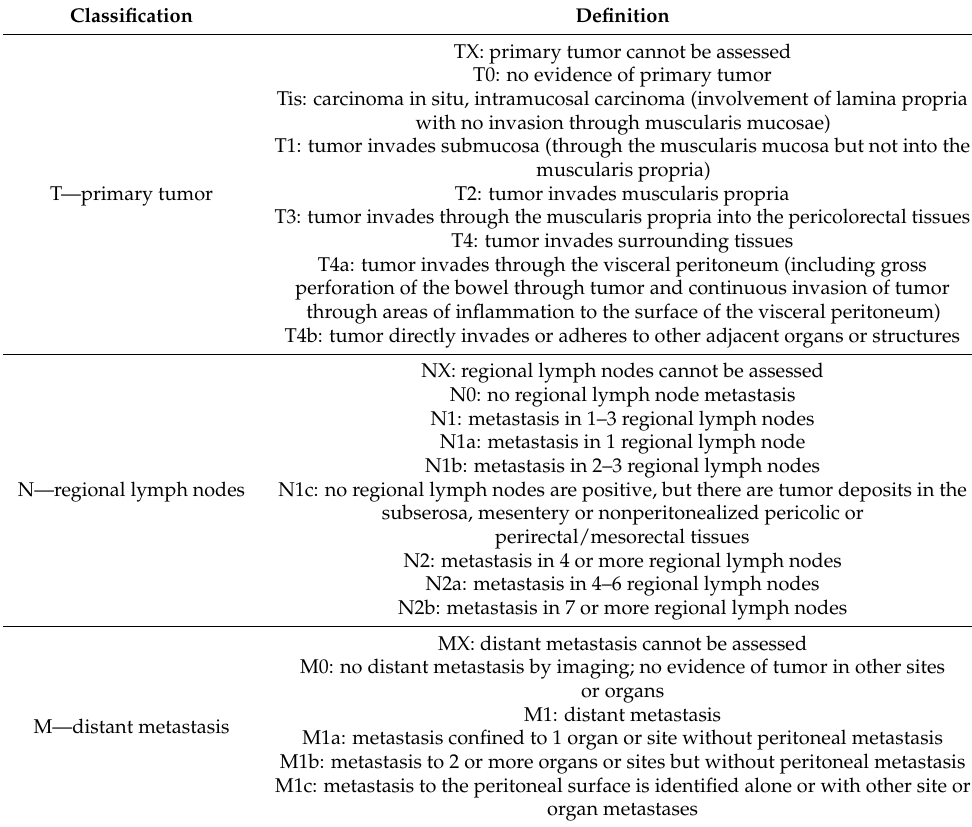
Table 1. Eighth edition of AJCC TNM